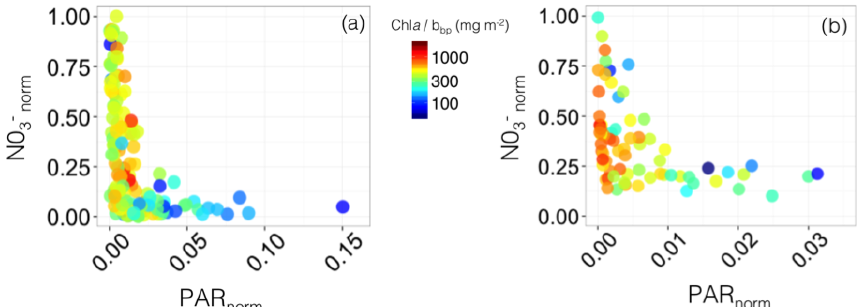
Figure 11. Nutrient vs. light resource-limitation diagram for the two BGC-Argo floats deployed in the Gulf of Lion (a) and Levantine Sea (b) . The colours of the data points indicate the Chl a : b bp ratio values. The x and y axes represent the PAR and [NO − maximum value calculated over the float lifetime in the layer extending from the surface to below the SCM. Note that the plots show only data collected within the SCM layer, thus corresponding to low normalized PAR values (i.e. under 25% of the maximum